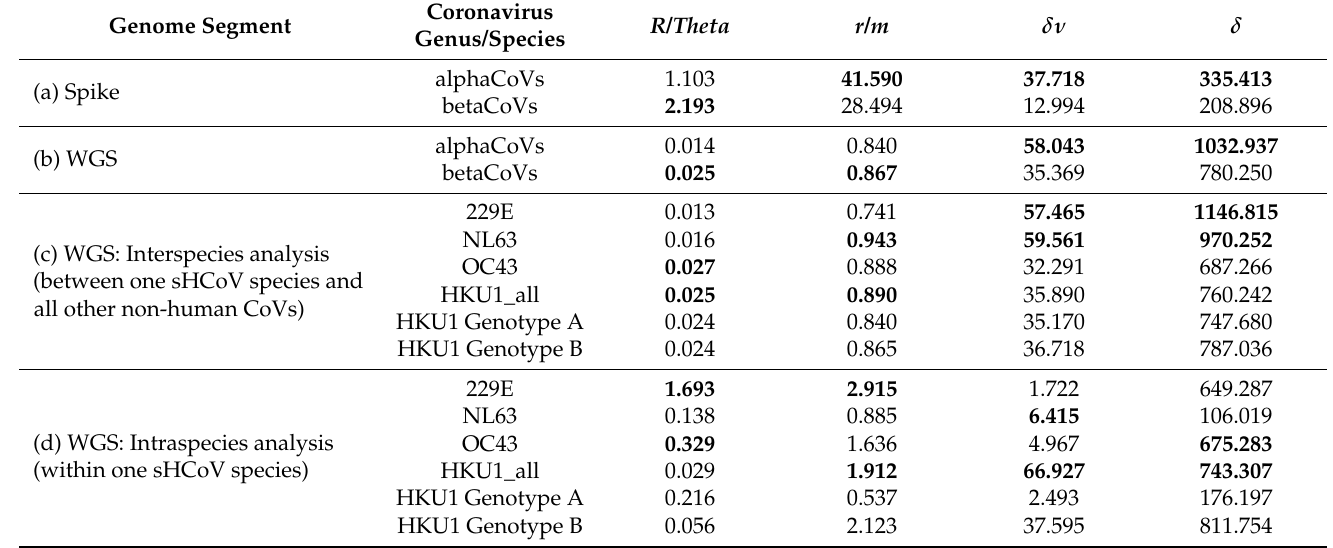
Table 2. Estimates of the ratio of recombination rate to point mutation rate ( R / theta ), substitutions by recombination relative to point mutation ( r / m ), number of substitutions per recombination event ( δν ), and mean length of DNA imported by homologous recombination ( δ ) from dataset D4. For each genome segment and analysis, the highest values are shown in bold. These analyses were conducted for the two HKU1 genotypes collectively (HKU1_all) and